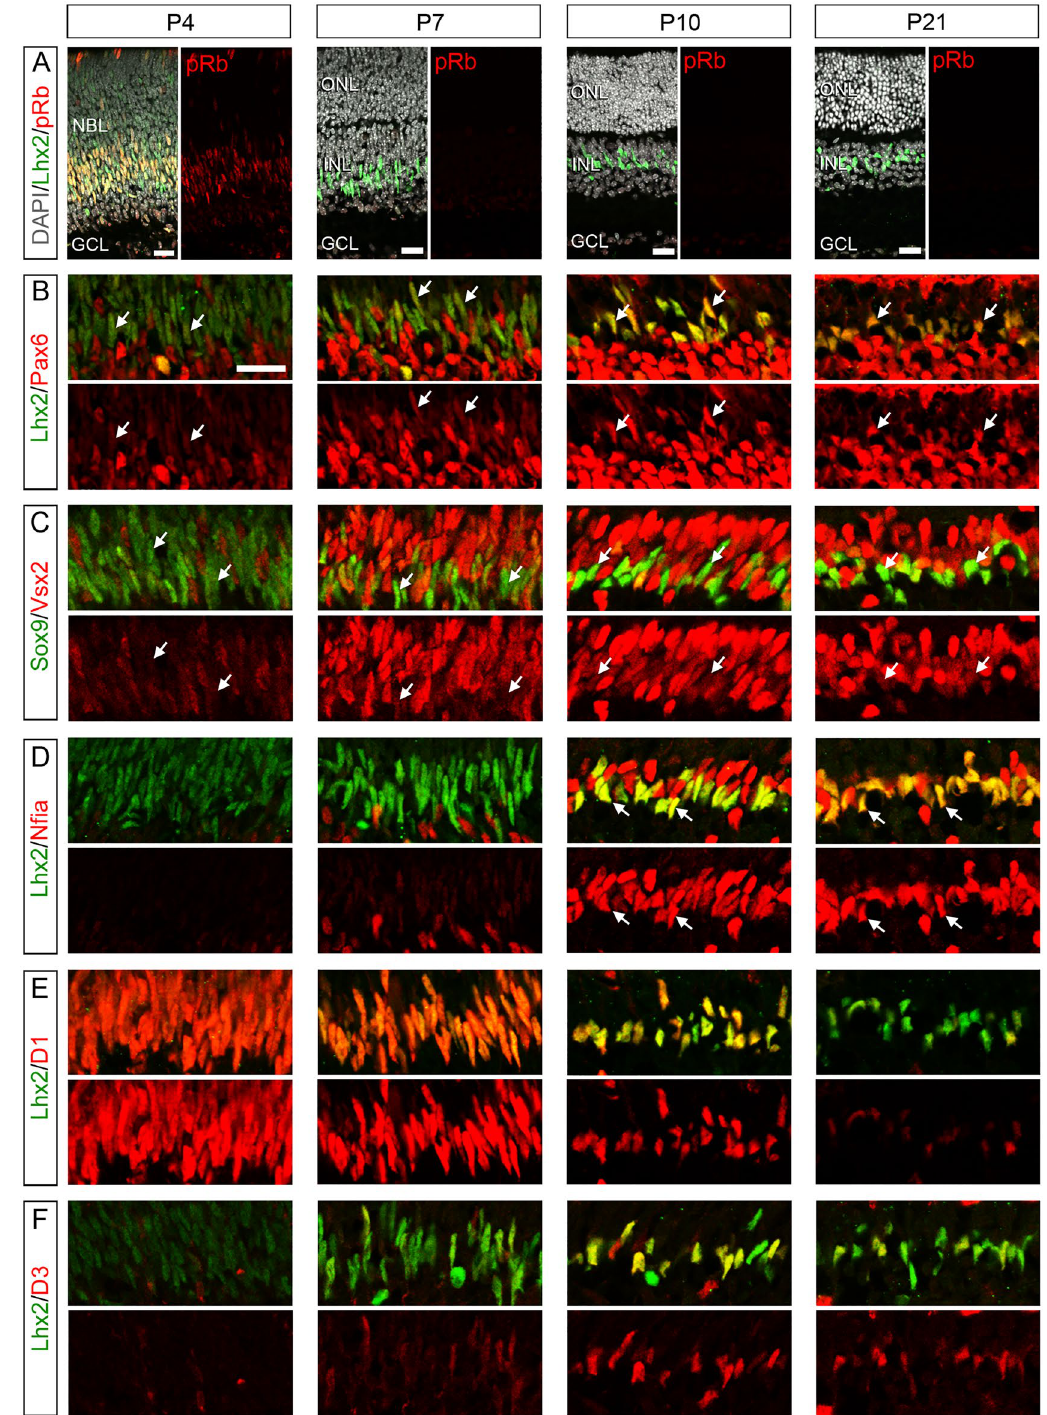
Figure 1. Immunofluorescence for RPC transcription factors and cell cycle regulators in Müller glia during development. ( A ) Lhx2+ cells at P4 are mostly phospho-pRb (pRb) + RPC while those after P7 are pRb− Müller glia. ( B ) Pax6 immunoreactivity in Lhx2 + RPC and Müller glia (arrows). ( C ) Vsx2 immunoreactivity in Sox9 + RPC and Müller glia (arrows). ( D ) Nfia immunoreactivity in Lhx2 + RPC and Müller glia (arrows). ( E ) Cyclin D1 immunoreactivity in Lhx2 + RPC and Müller glia. ( F ) Cyclin D3 immunoreactivity in Lhx2 + RPC and Müller glia. NBL neuroblastic layer, GCL ganglion cell layer, ONL outer nuclear layer, INL inner nuclear layer. Scale bar = 20